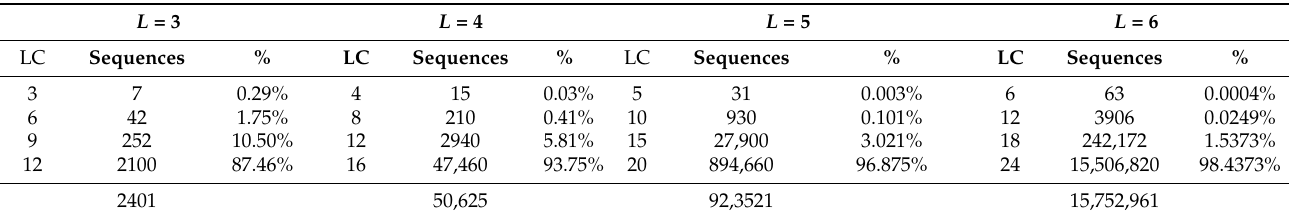
Table A2. Number and percentage of 4-interleaving sequences with different values of LC , formed by PN-sequences with characteristic polynomials of degree L = 3,4,5,6.